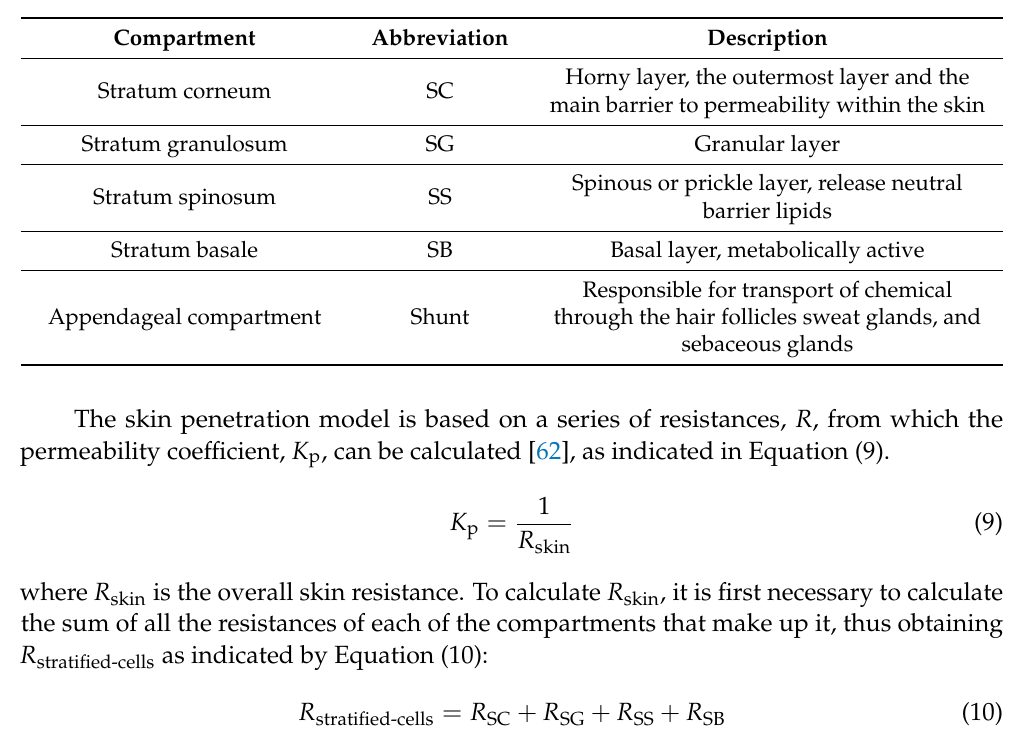
Table 2. Compartments of epidermis, their abbreviations, and descriptions of each